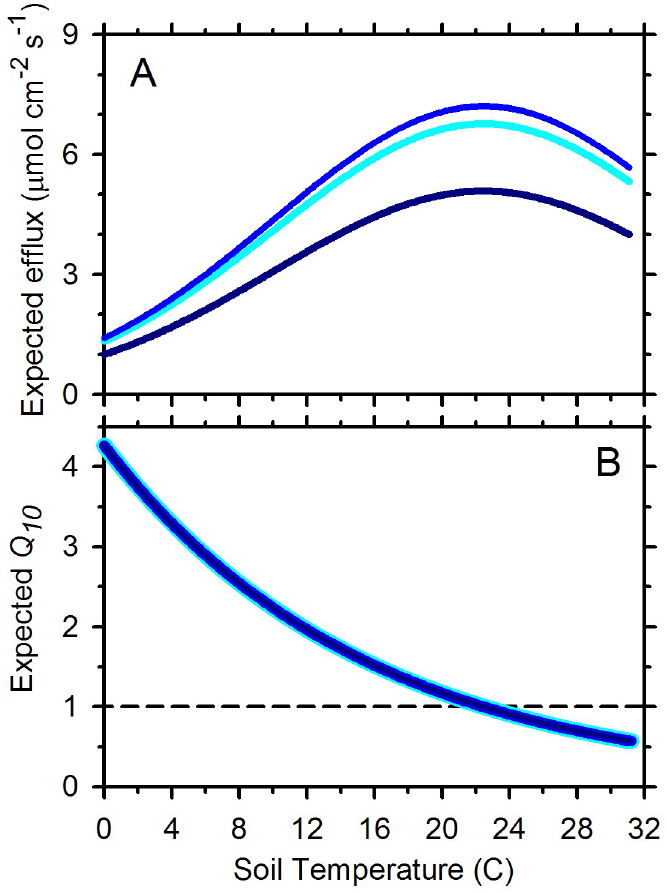
Fig 3. Expected relationships between soil-CO 2 emissions and temperature at three levels of soil volumetric water content based on the main-effects model. (A) Expected Rsoil in relation to soil temperature at low, medium and high soil volumetric water contents. The temperature at maximum flux was 22.5˚C regardless of soil water content. (B) The Q 10 of emissions declined as temperature increased, but did not vary with water content. The plotted relationships show the midpoints of 10˚C intervals, i . e ., the Q 10 at X = 2˚C is the ratio of the expected fluxes at 7 and -3˚C. Note that the individual relationships for low, medium, and high water contents overlie one another. The horizontal dotted line identifies Q = 1, below which estimated fluxes were lower at warmer 10